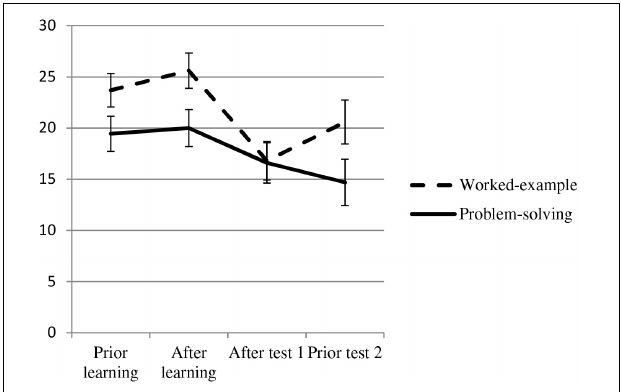
FIGURE 8 | Change in performance expectancies by learning conditions. Error bars represent the standard error of the mean. Values could range from expecting 0 points to 42 points in the performance